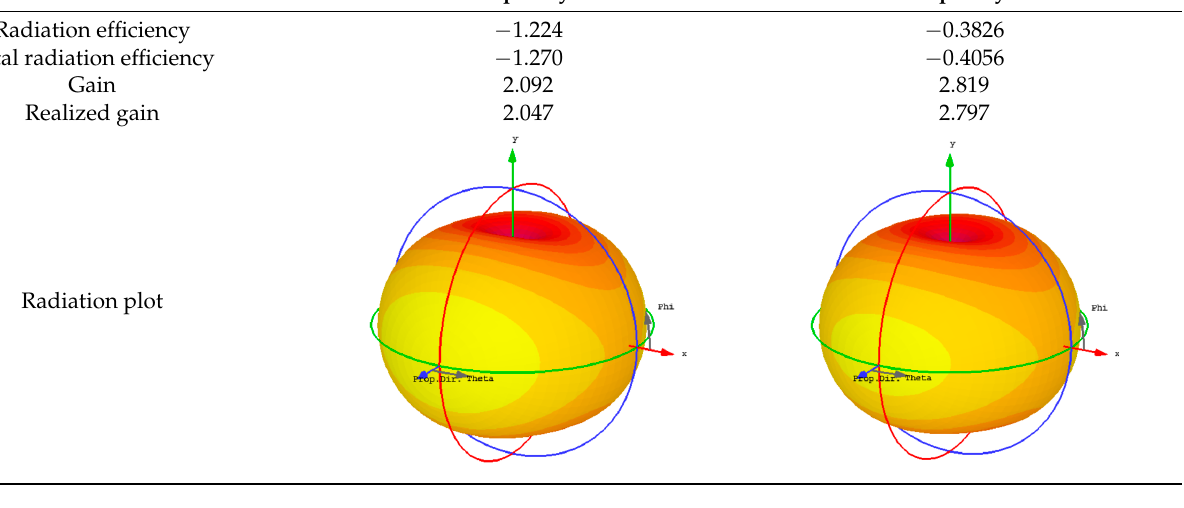
electrical disturbance, drift error, etc. Figure 9. Dispersive loss tangent for the proposed split ring enclosed microwave sensor. Table 2. Different radiation properties for the proposed sensor. Resonant Frequency at 3.56 GHz